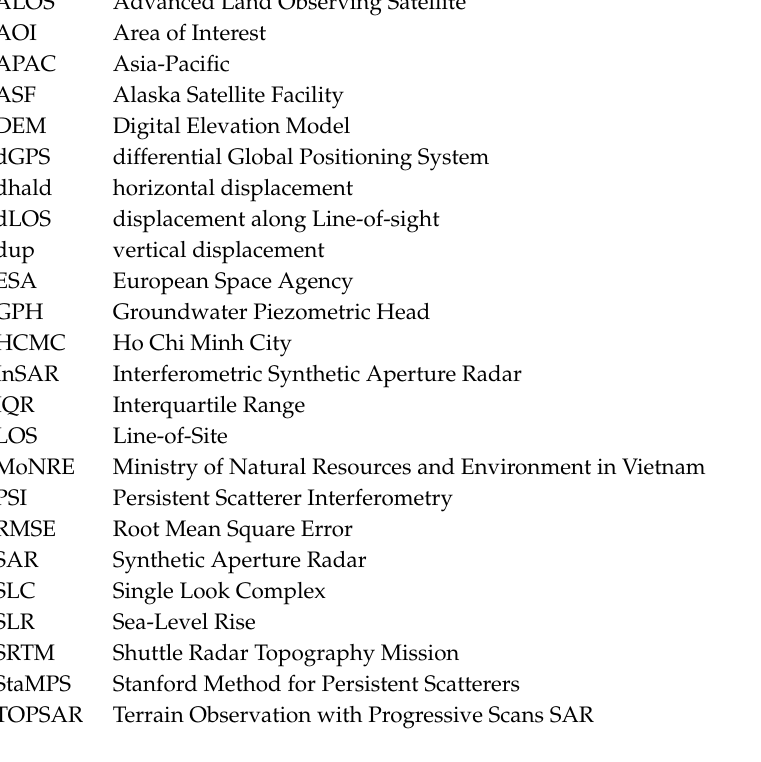
Figure S1: Vertical velocities of reference points for validation proxy, Figure S2: Spatial distribution of reference points, Figure S3: Temporal analysis in District 8-an area of rapid subsidence, Figure S4: Interferograms of unwrapped